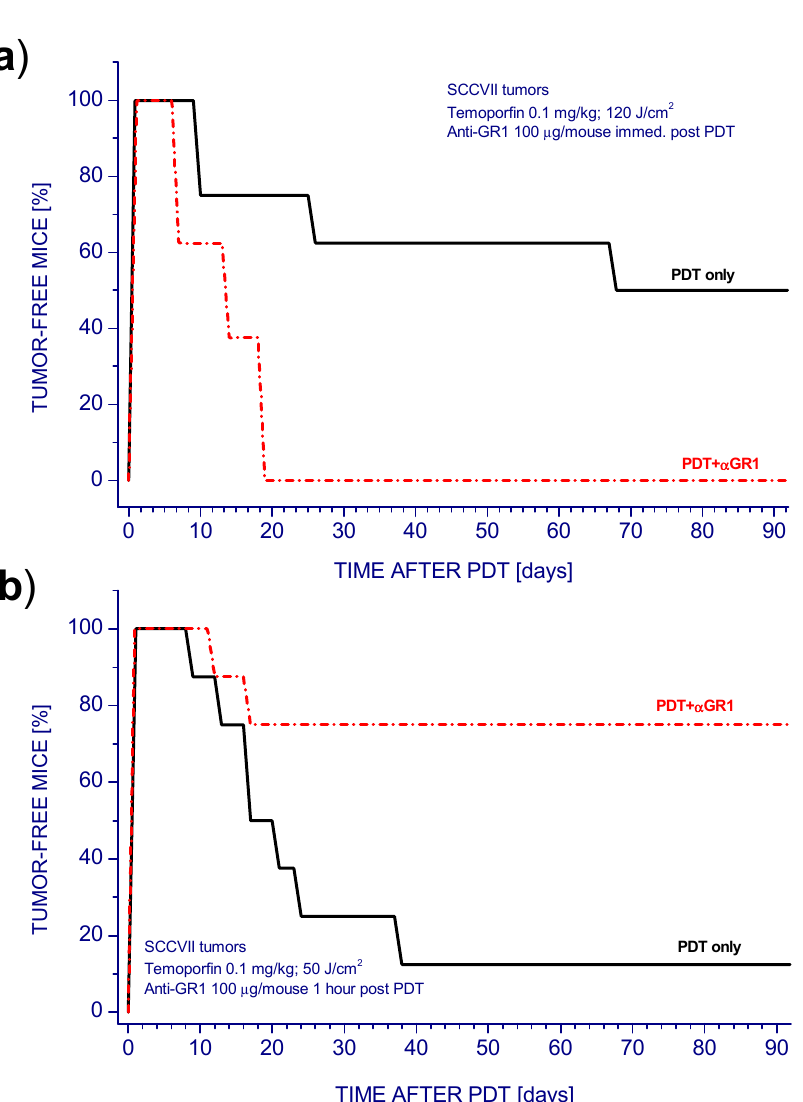
Figure 1. The effect of anti-GR1 antibody on photodynamic therapy (PDT) response of SCCVII tumors. Mice bearing SCCVII tumors were administered Temoporfin (0.1 mg/kg i.p.) and 24 h later the tumors were illuminated with 650 ± 10 nm light. Anti-GR1 was given i.v. at the dose of 0.1 mg/mouse. ( a ) PDT light dose 120 J/cm 2 and anti-GR1 injected immediately after light treatment; ( b ) PDT light dose 50 J/cm 2 and anti-GR1 injected 1 h after light treatment. Mice (8 per group) were monitored up to 90 days for tumor growth. There were statistically different responses ( p < 0.05) for PDT alone compared to PDT plus anti-GR1 groups in both graphs.